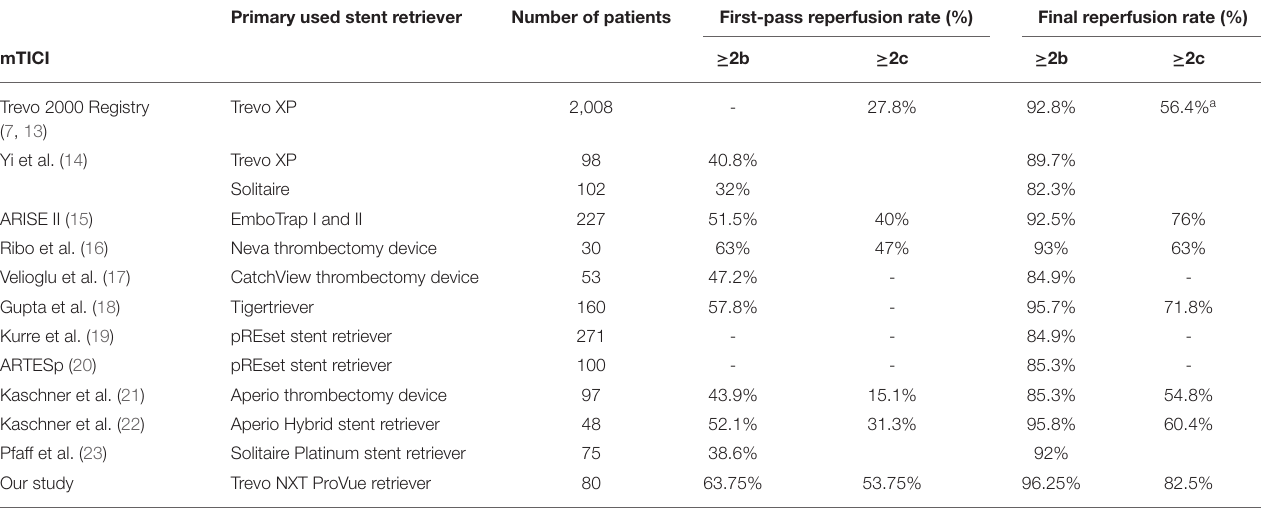
TABLE 4 | Overview of recent studies evaluating stent retrievers. Primary used stent